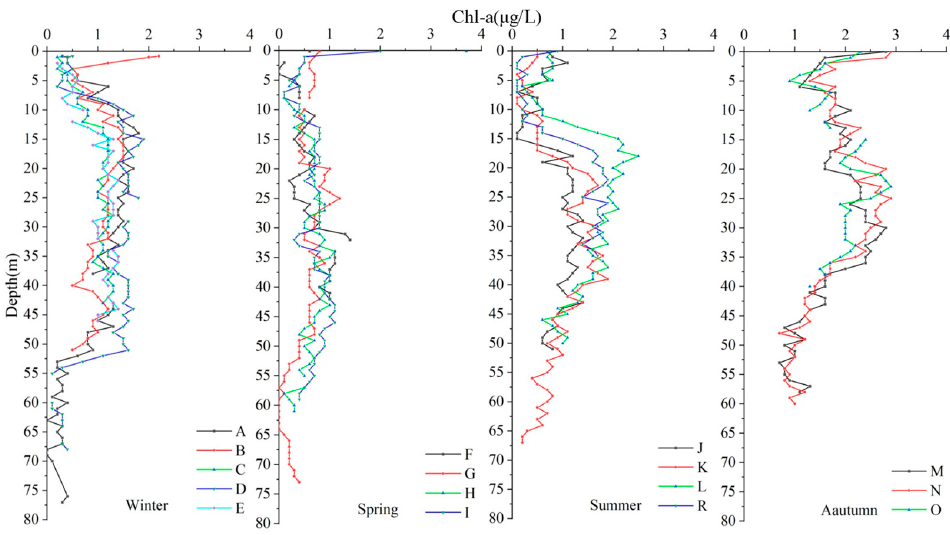
Figure 6. Seasonal variations in vertical chlorophyll- a (Chl- a ) in Lake